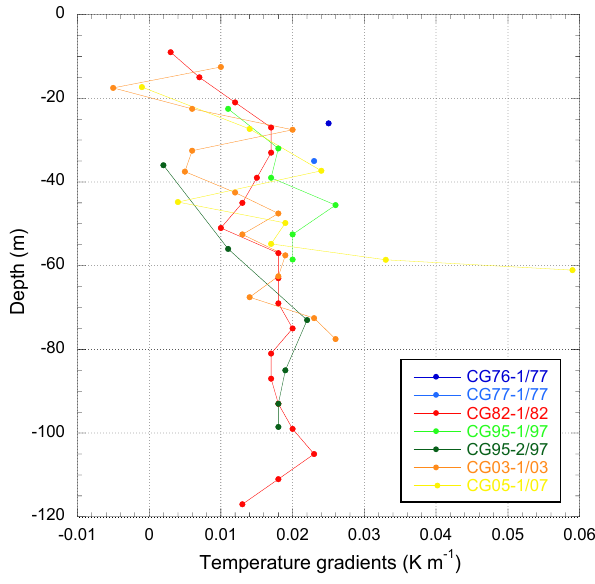
Fig. 11. Calculated temperature gradients for the temperature pro- files shown in Fig. 10 with CG77-1/77 and CG77-2/77 (Oeschger et al., 1977), CG81-1/82 (Haeberli and Funk 1991), CG95-1/97 and CG95-2/97 (L¨uthi, 2000), CG03-1/03 (Schwerzmann, 2006) and CG05-1/07 (this study).